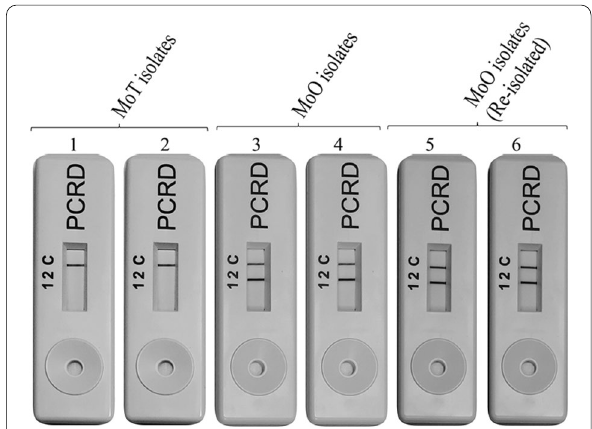
Fig. 6 Rapid detection of MoT by PCRD strip. Lanes 1 and 2 signify DNA isolated from MoT strains BTJP4‑5 and BTMaU(10b), respectively. The MoO isolates, RB13b and RBTa1849‑2 specify lane 3 and 4 separately, which were collected from naturally blast infected rice panicles (double band indicate MoT negative results). Moreover, lanes 5 and 6 denote DNA reisolated from the symptomatic tissues of wheat spikes artificially inoculated with MoO strains RB13b and RBTa1849‑2, respectively (double band indicate MoT negative